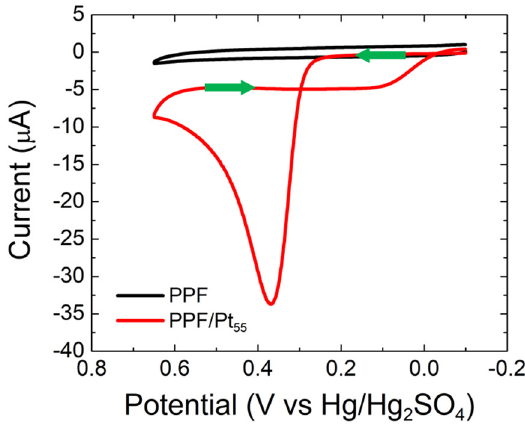
Figure 3. CVs obtained for CO electrooxidation on bare PPF and PPF/Pt 55 electrodes. The solutions contained aqueous, CO-saturated 0.10 M HClO 4 . The electrode potential was scanned between –0.10 and 0.65 V at 0.050 V/s. The experiments were carried out in triplicate for each electrode configuration using independently prepared electrodes to ensure reproducibility.